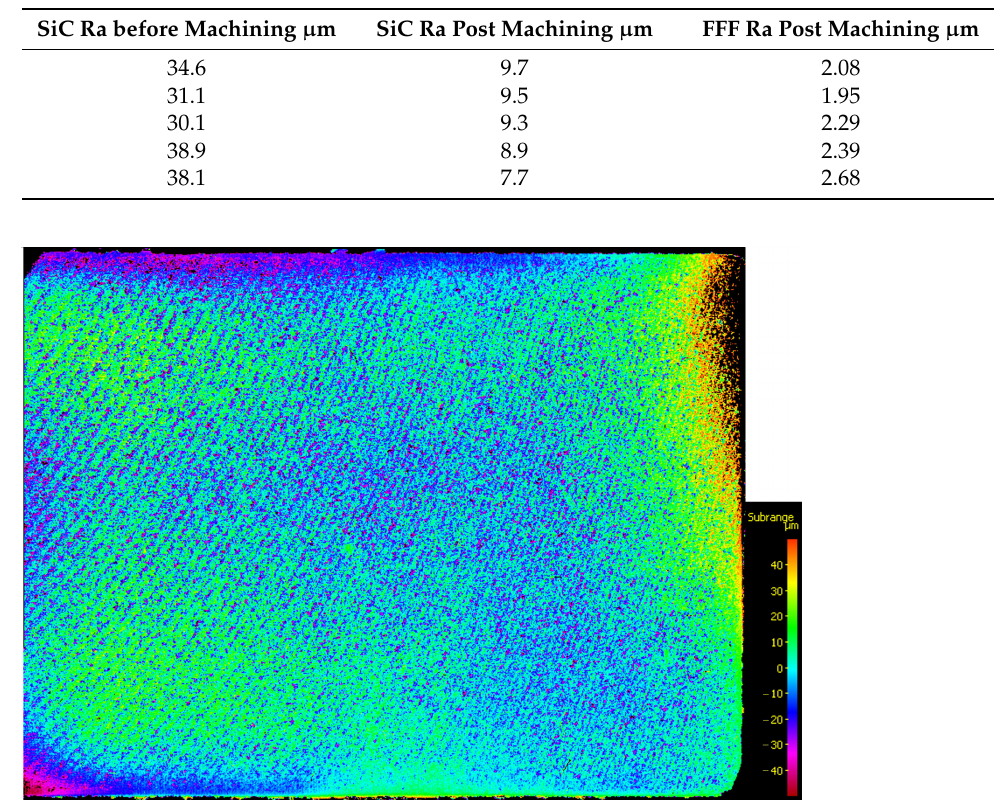
Table 3. Results for surface roughness of SiC sample before and after machining and FFF sample after machining.